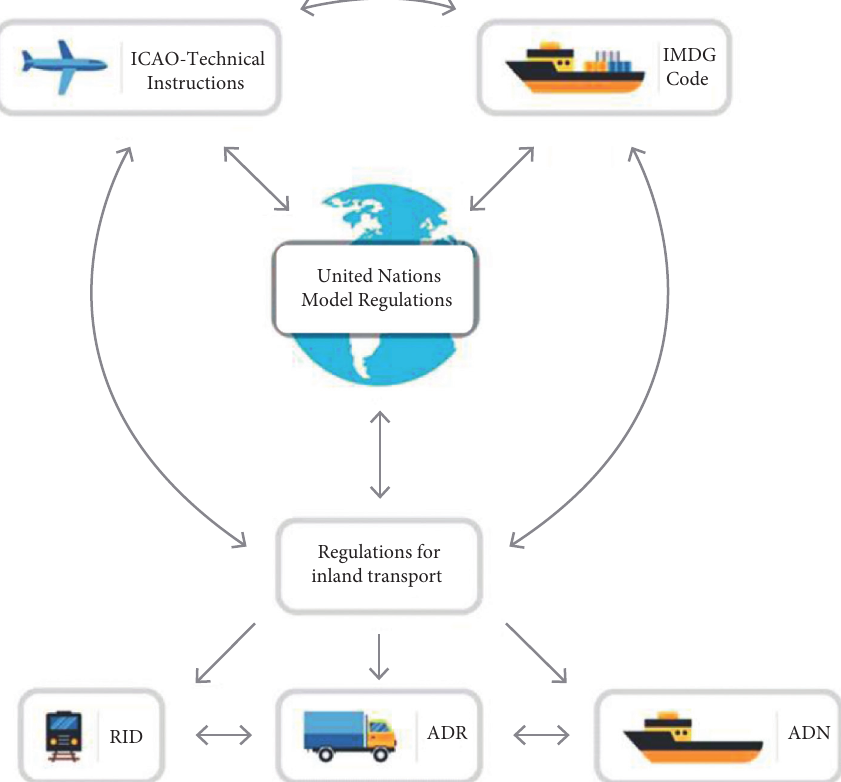
Figure 2: International regulations on the transport of dangerous